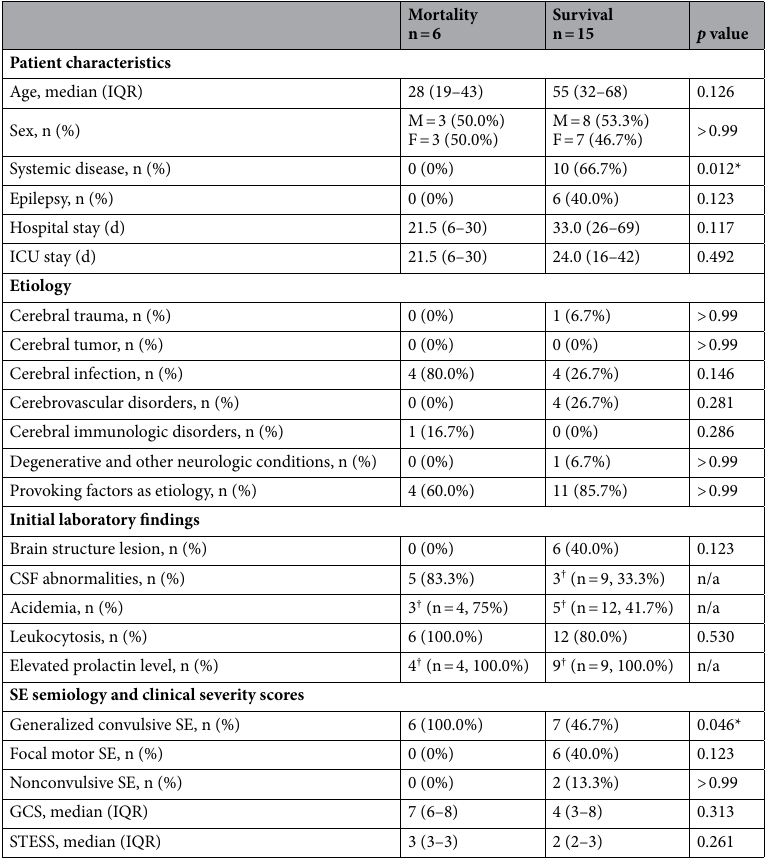
Table 1. Characteristics, laboratory findings, SE etiologies and severities in patients with SRSE. n number, F female, M male, IQR interquartile range, ICU intensive care unit, CSF cerebrospinal fluid, SE status